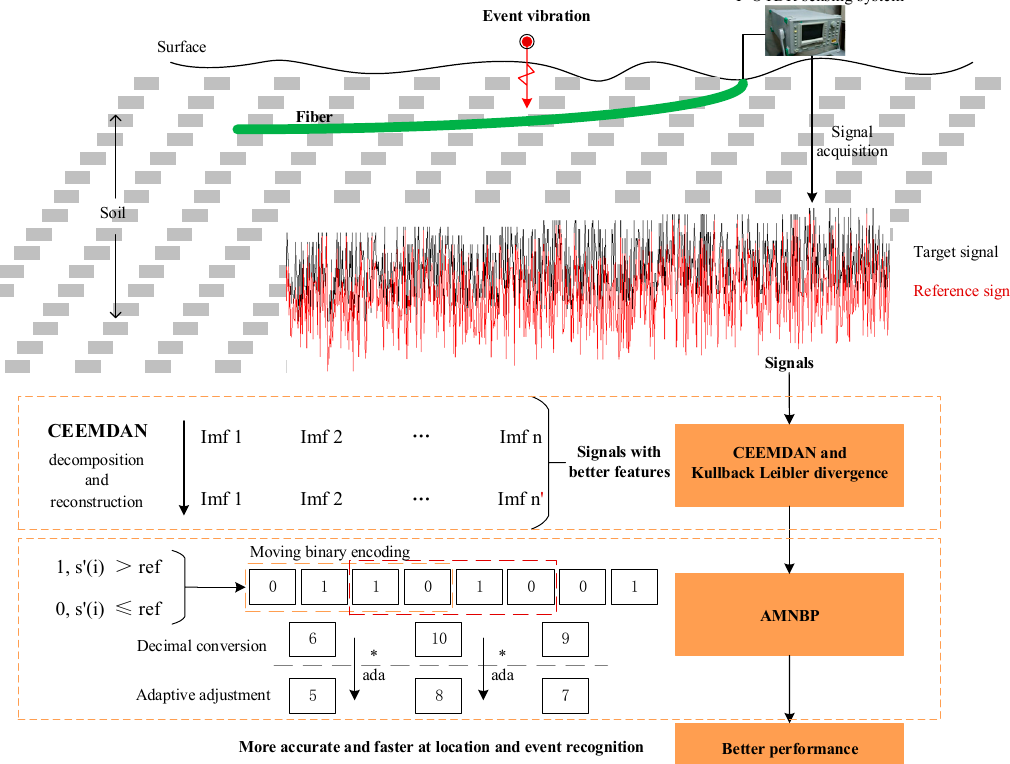
Figure 1. Schematic of the process used. Φ -OTDR: Phase-sensitive optical time-domain reflectometry, CEEMDAN: Complete ensemble empirical mode decomposition with adaptive noise KL: Kullback Liebler, MNBP: Moving neighbor binary